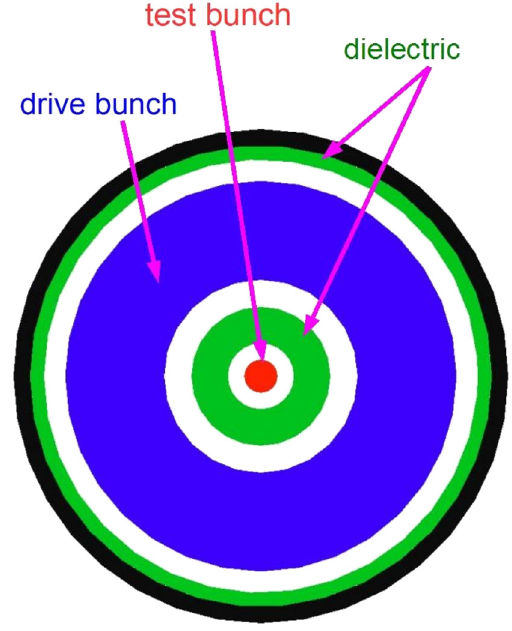
FIG. 1. (Color) Cross section of a coaxial DWFA. Dielectric tubes are green, drive bunch is blue; test bunch is red, and black outer shell is